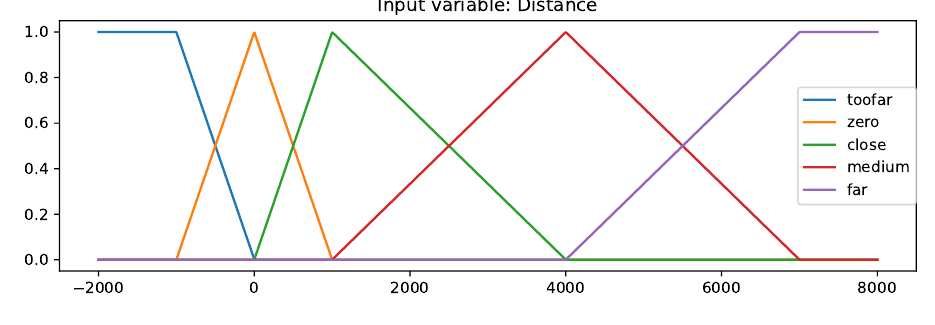
Figure 3. Distance input